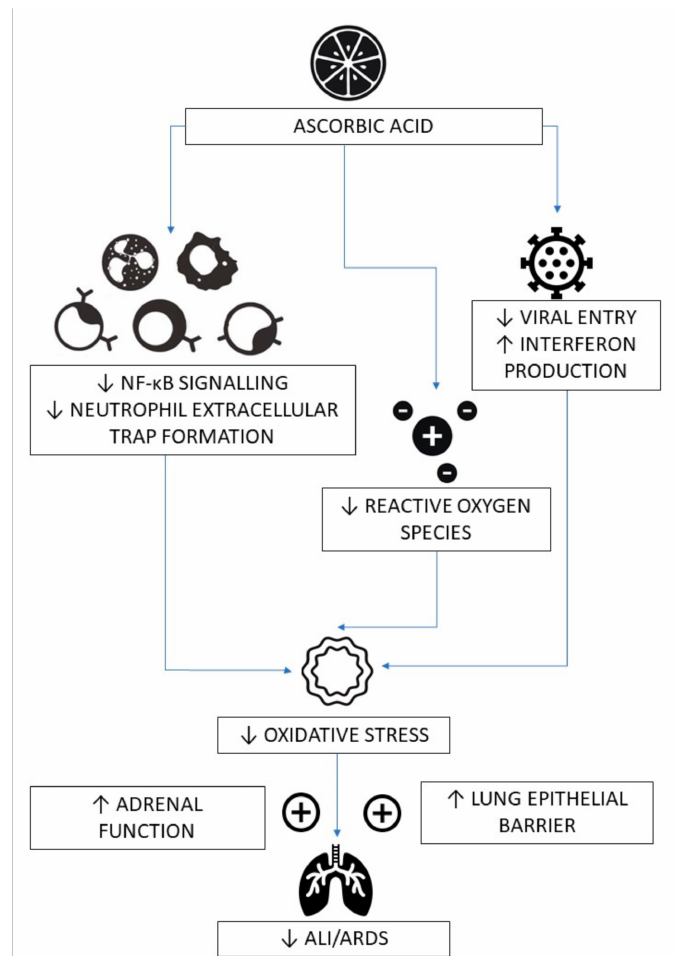
Figure 1. Postulated mechanisms for vitamin C’s amelioration of COVID-19 pathology. ↓ —decreased; ↑ —increased; ALI—acute lung injury; ARDS—acute respiratory distress syndrome; NF- κ B—nuclear factor kappa